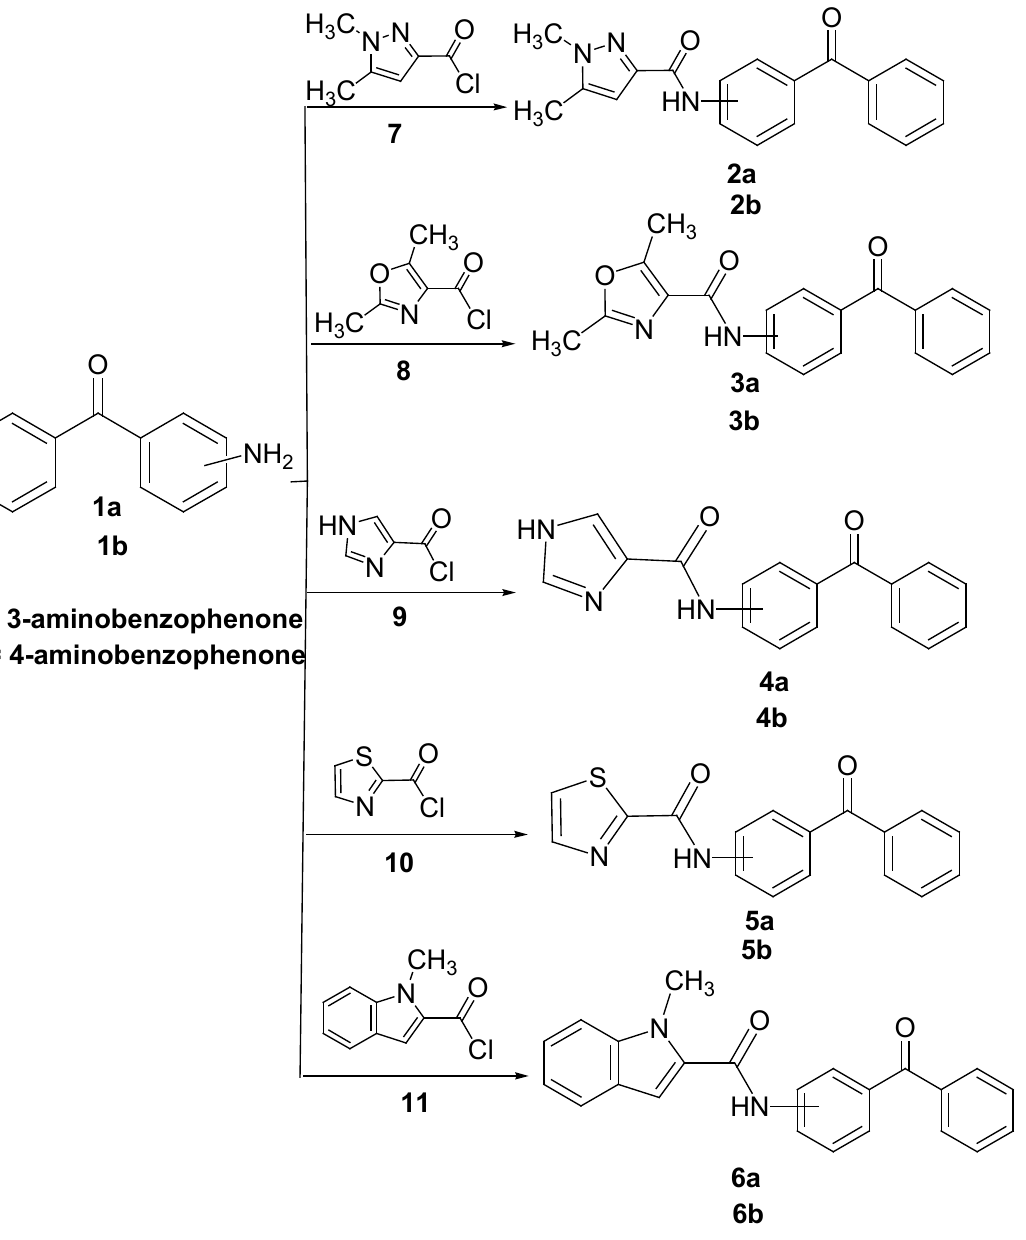
Scheme 1 - Synthesis of the target compounds 2-6 (a,